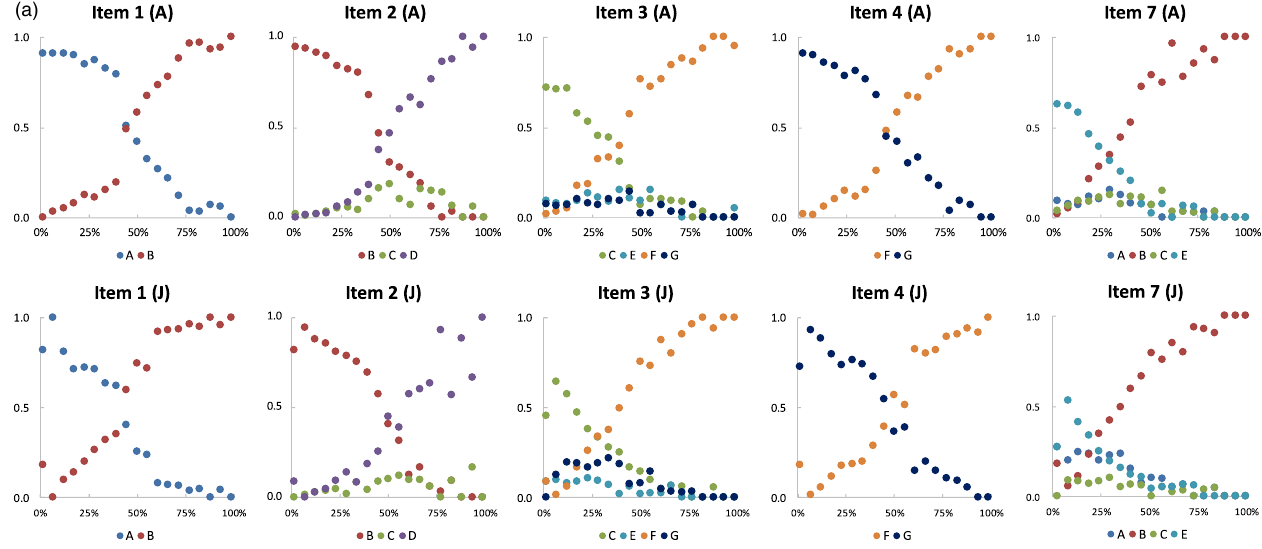
FIG. 3. (a). IRCs for the force sled item cluster. A, American students; J, Japanese students. (b). IRCs for the reverse direction item cluster. A, American students; J, Japanese students. (c). IRCs of the force graphs item cluster. A, American students; J, Japanese students. (d). IRCs of the acceleration graphs item cluster. A, American students; J, Japanese students. (e). IRCs of the Newton III item cluster. A, American students; J, Japanese students. (f). IRCs of the velocity graphs item cluster. A, American students; J, Japanese students. (g). IRCs of the Energy item cluster. A, American students; J, Japanese students. (h). IRCs of unscored items. A, American students; J, Japanese